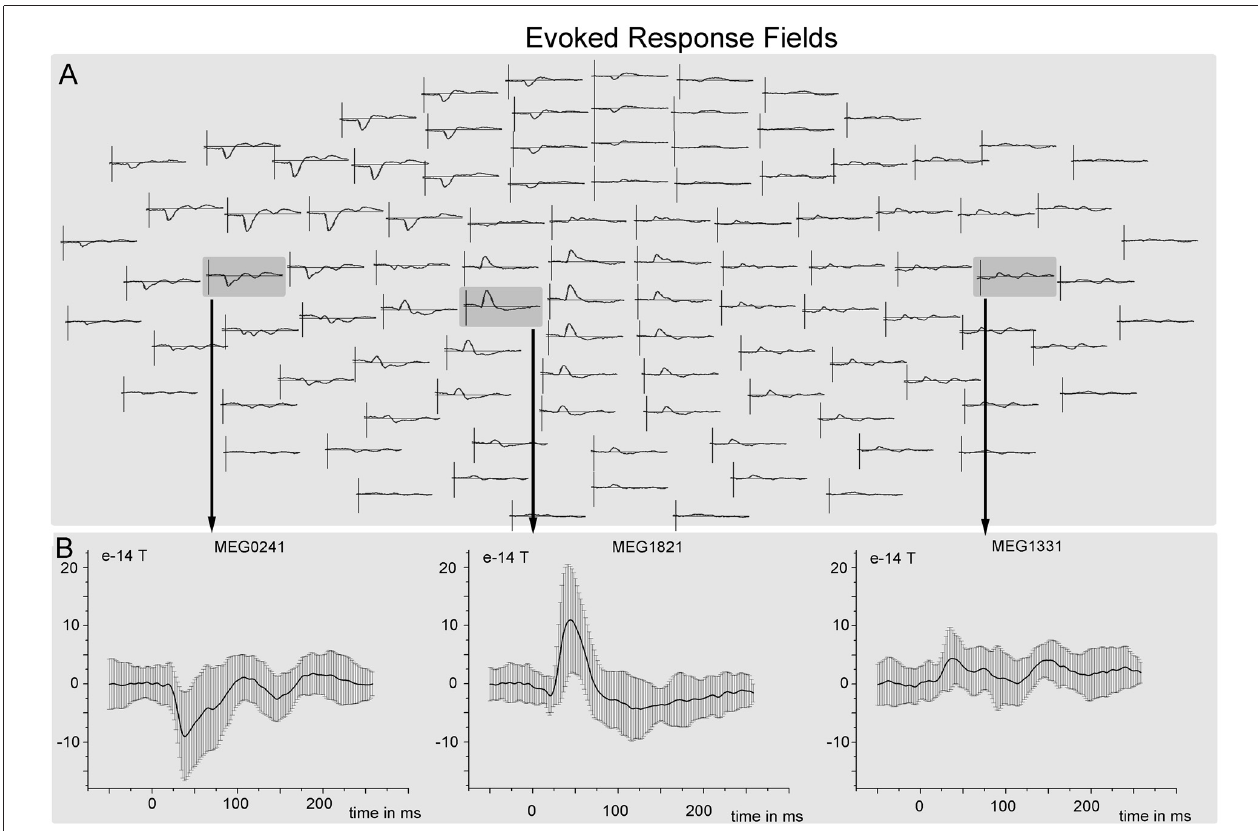
FIGURE 5 | Grand mean event related fields (ERFs). (A) ERF responses (averaged over all trials and subjects) to tactile stimulation of the left hand overlaid on a whole scalp map of 102 MEG sensors. (B) ERF responses with standard deviation from three different sensors that are located nearest to the three sources (SIIc—sensor MEG0241, SIc—sensor MEG1821, SIIi—sensor